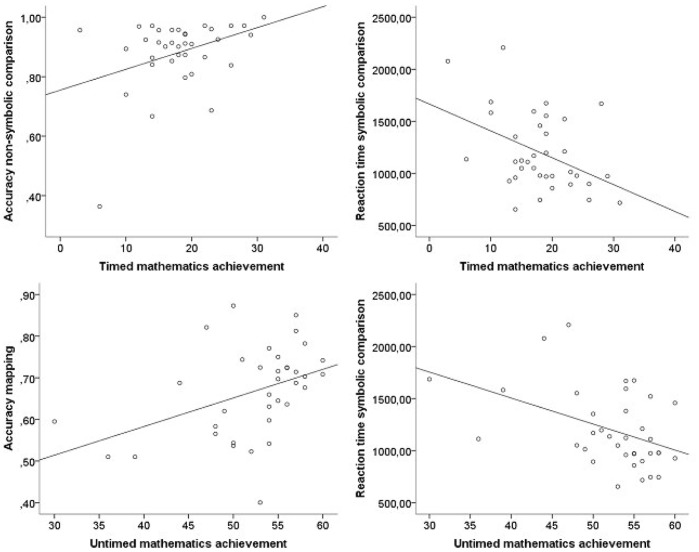
Scatterplots showing the significant associations between the numerical magnitude processing tasks and timed (top panels) and untimed (bottom panels) mathematics achievement in Grade 1.